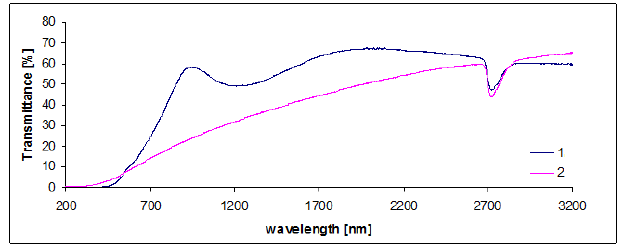
Figure 3. Transmittance spectra of PVD (1) and CVD (2)